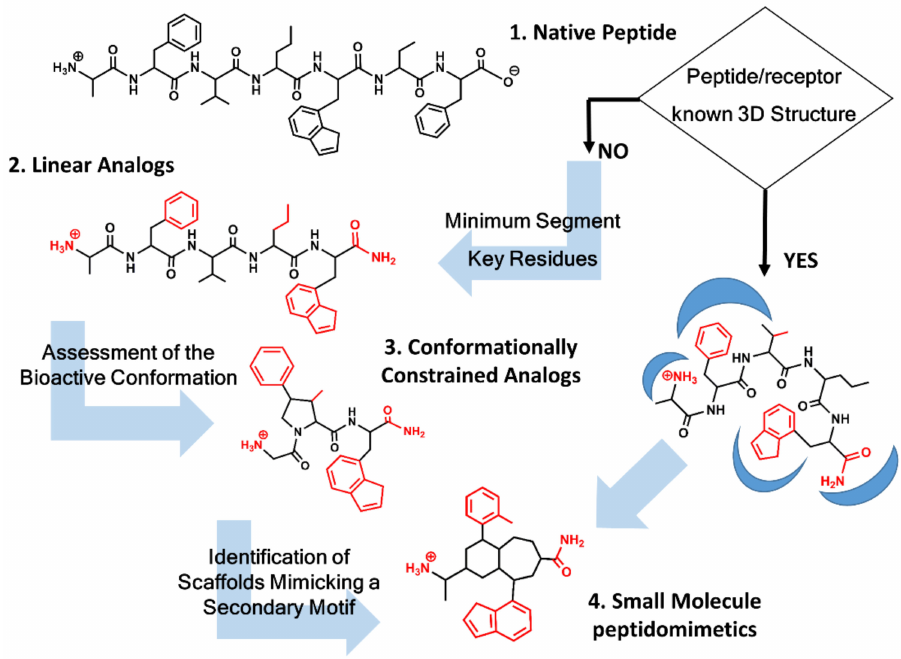
Figure 1. Peptidomimetics design roadmap. Starting from the native peptide sequence ( 1 ) when the 3D structure of the peptide/receptor complex is not known, first step regards the synthesis of linear analogs ( 2 ) to establish the shortest peptide fragment with activity and to identify key residues for receptor recognition (in red). Next step consists of designing conformationally constrained analogs ( 3 ), using information about the secondary structure of the peptide in its bound conformation. The final step is the identification of small molecule scaffolds ( 4 ) that permit a correct spatial arrangement of relevant chemical groups. Knowledge of the peptide/receptor 3D structure permits to undertake a